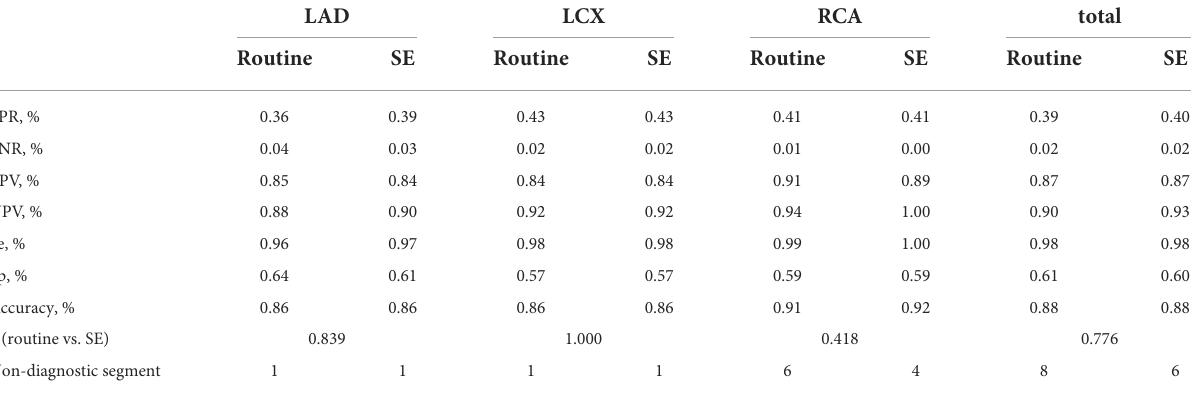
TABLE 5 Comparison of diagnostic accuracy among the routine group, SE group, and the DSA group for coronary artery stenosis on per-segment and total levels. LAD LCX RCA SE